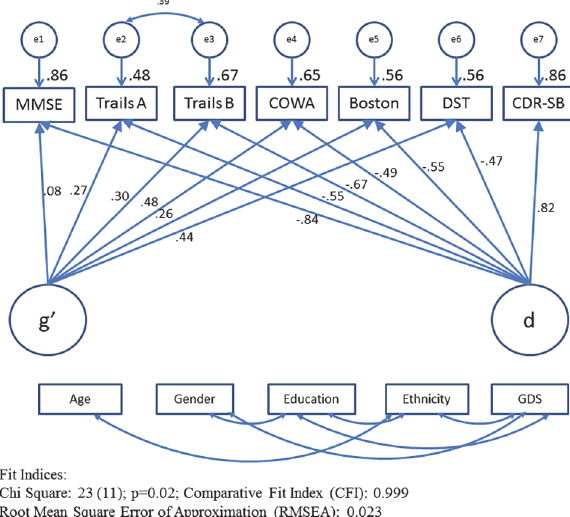
Fig 1. Confirmatory Factor Analysis. All observed variables were adjusted for age, gender, education, ethnicity and geriatric depression scale (GDS) scores (paths not shown for clarity). Abbreviations: BOSTON, Boston Naming Test; CDR-SB, Clinical Dementia Rating scale sum of boxes; COWA, Controlled Oral Word Association Test; DST, Digit Span Test; MMSE, Mini-Mental Status Examination; Trails A, Trail Making Test A; Trails B, Trail Making Test